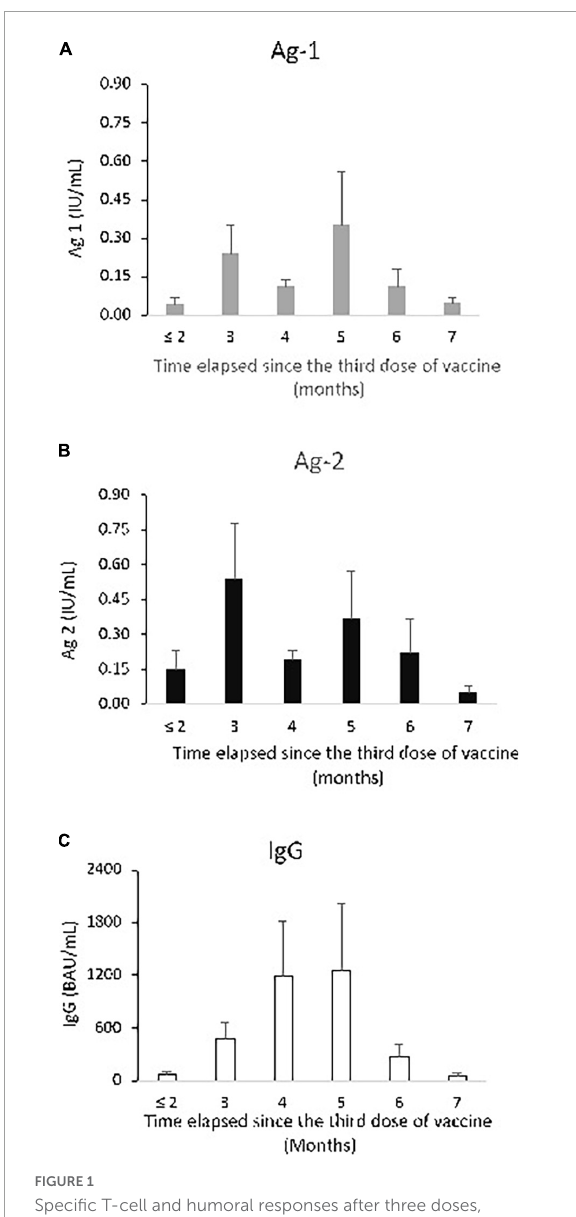
FIGURE1 Specific T-cell and humoral responses after three doses, according to time elapsed since vaccination. Specific T-cell response as stimulated IFN- γ release: (A) QuantiFERON response to antigen 1, (B) QuantiFERON response to antigen 2, given in IU/mL. (C) Serological responses: Anti-SARS-CoV-2 IgG response, given in binding antibody units per mL (BAU/mL), at month ≤ 2 to month 7 after vaccination. The three dosages were done in the same Heart transplant patients [ n = 9–20 per group, except for month 7 ( n = 5)]. Mean ± SEM are